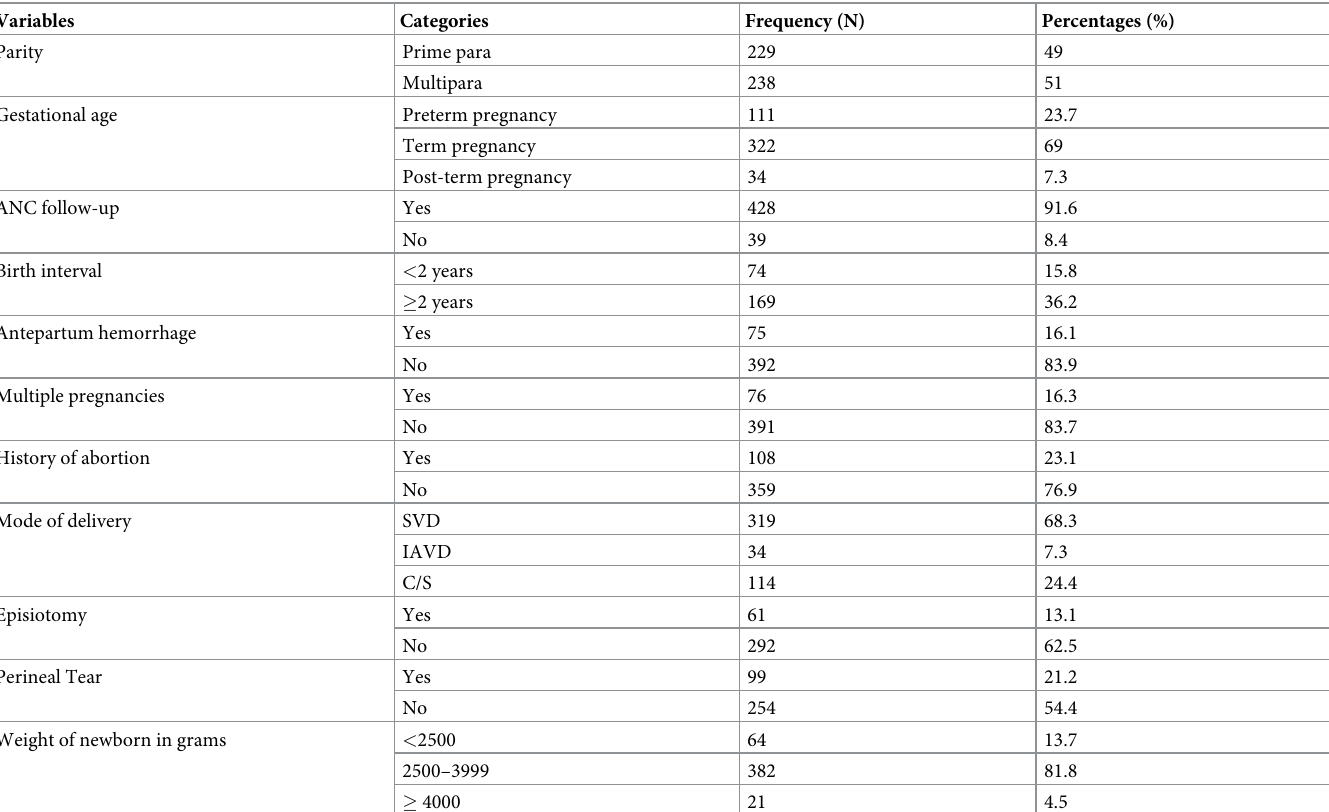
Table 2. Obstetrics characteristics related variables of immediate postpartum women in East Gojjam zone hospitals Northwest Ethiopia 2020 (n = 467).